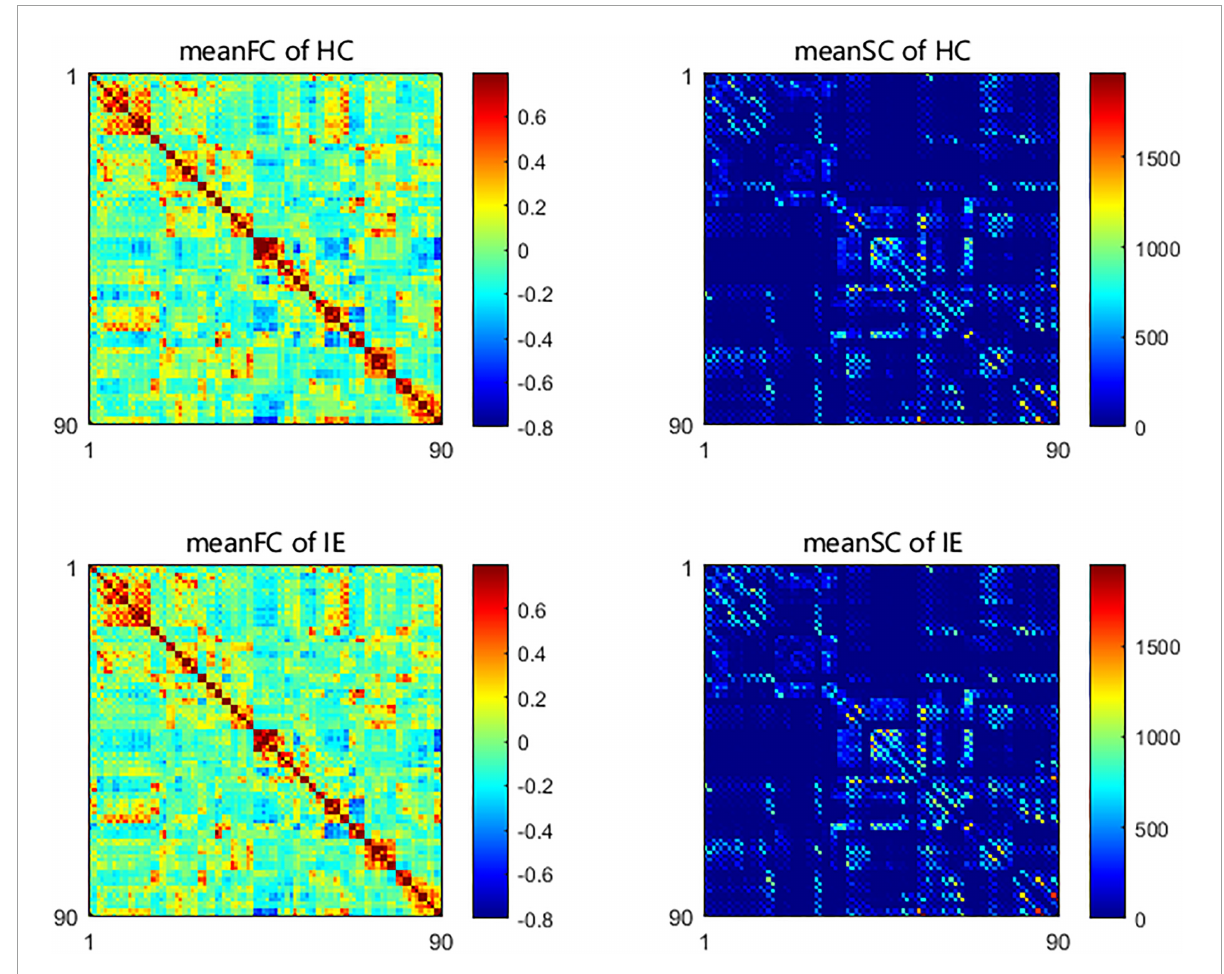
FIGURE1 Group-averaged network connectivity matrices based on Automated Anatomical Labeling (AAL) atlas in patients with infantile esotropia and healthy participants. The functional connectivity matrices were constructed with link weights of correlation between time series from pairs of brain areas. The structural connectivity matrices were established with edge weights of fractional streamline count between paired brain regions. SC, structural connectivity; FC, functional connectivity; HC, healthy control; IE, infantile